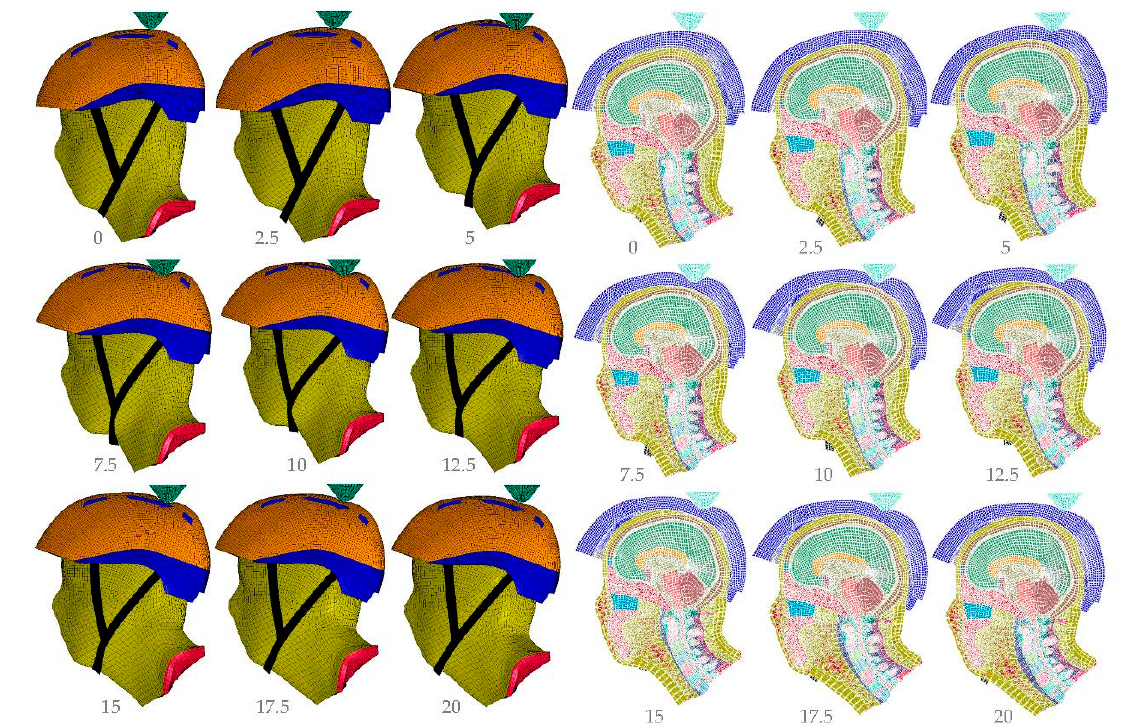
Figure 7. EN 1078 curbstone anvil graphical sequence results (ms).